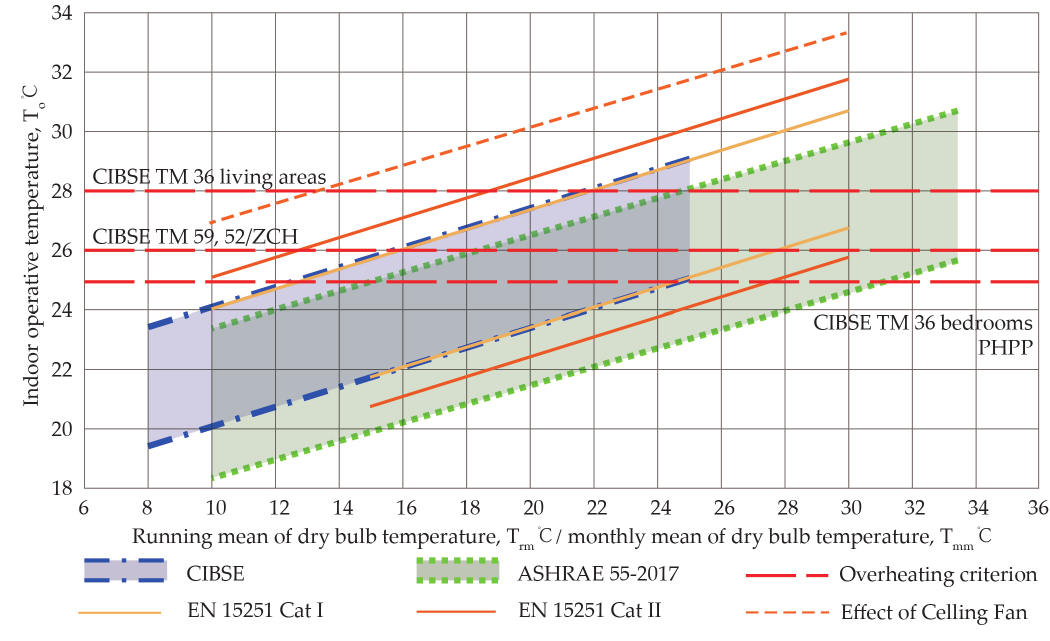
Figure 2. Thermal comfort and overheating criteria. (Data source: CIBSE TM36 (Chartered Institution of Building Services Engineers Technical Memorandum), CIBSE TM52, CIBSE TM59, ASHRAE 55-2017 (American Society of Heating, Refrigerating and Air-Conditioning Engineers), EN 15251 (European Standards), Passive House Planning Package (PHPP), and Zero Carbon Hub (ZCH); drawn by the